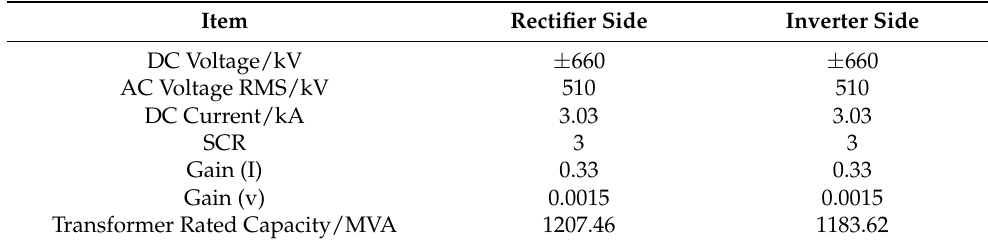
Table 1. Table 1. Parameters of LCC-HVDC model. Table 1. Parameters of LCC-HVDC model.